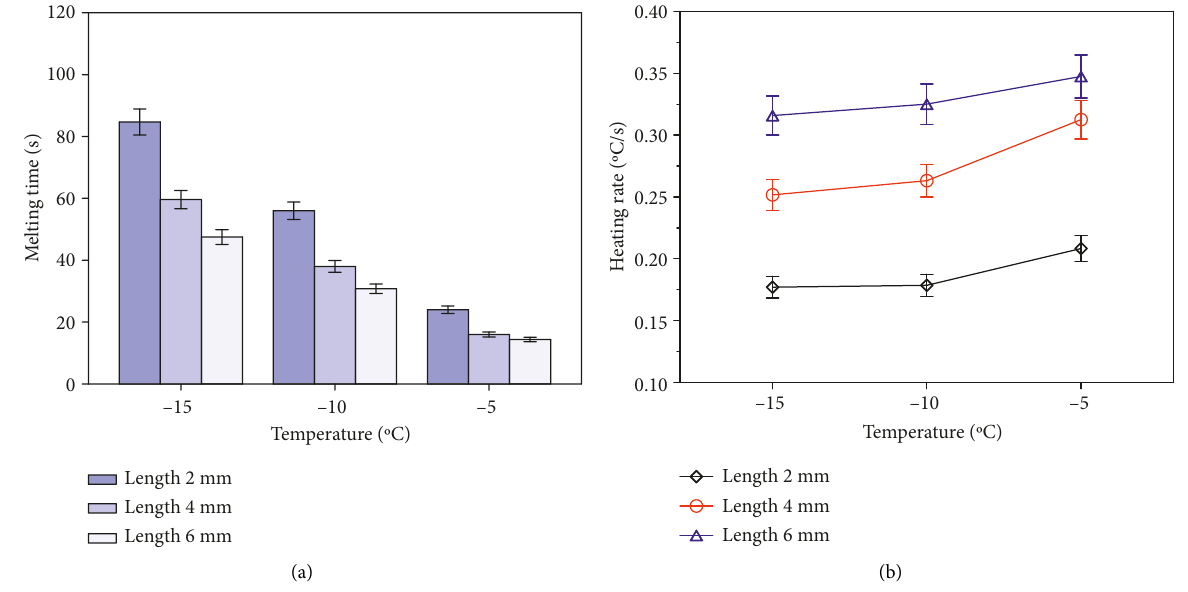
Figure 7: Ice-melting performance at different ambient